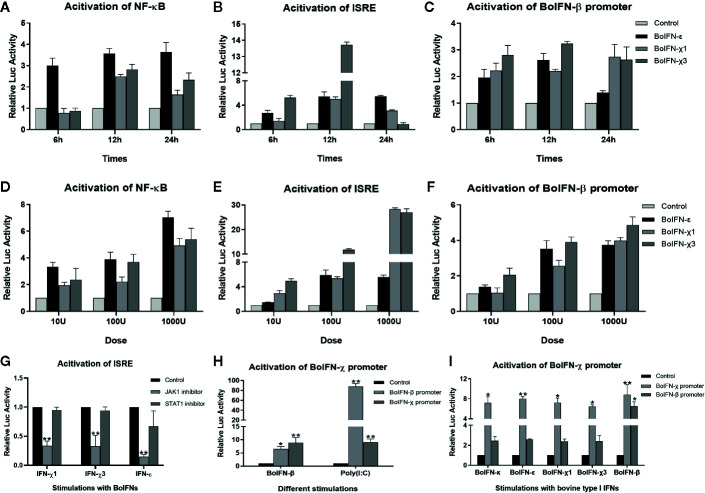
Promoter activation with BoIFN-χs. (A–F) Time/dose dependence of activation of promoters of BoIFN-β (pGL3-BoIFNβ)/ISRE (pISRE-TA-Luc)/NF-κB (pNFκB-TA-Luc) upon BoIFN-χs treatment. BL cells were transfected with 1.6 μg pGL3-BoIFNβ/pISRE-TA-Luc/pNFκB-TA-Luc and 0.04 μg of pRL-SV40-Renilla for 24 h, and then, cells were incubated with a different dose of BoIFN-χ1 and BoIFN-χ3 for different times. Then, the cells were collected for dual-luciferase reporter assay. BoIFN-ϵ was used as positive control. (G) Activation of the ISRE (pISRE-TA-Luc) promoter in BL cells upon BoIFN-χs treatment followed by treatment with a STAT1/JAK1 inhibitor. BL cells were pretreated with JAK1/STAT1 inhibitor for 2 h following treatment with BoIFN-χ1 (5 μg/mL) and BoIFN-χ3 (5 μg/mL) for another 12 h, and the cells were collected for dual-luciferase reporter assay. BoIFN-ϵ (5 μg/mL) was used as a positive control, and the cells without inhibitors were used as a mock-treated control. (H) Activation of the BoIFN-χ (pGL3-BoIFNχ) promoter. BL cells were transfected with 1.6 μg pGL3-BoIFNχ/pGL3-BoIFNβ and 0.04 μg of pRL-SV40-Renilla for 24 h, and then. BoIFN-β (5 μg/mL)/poly(I:C) (1 μg/mL) were incubated for another 12 h, and the cells were collected for dual-luciferase reporter assay. The cells transfected with pGL3-BoIFNχ were used as positive control, and the cells transfected with pGL3-basic vector were used as mock-treated control. (I) Activation of the BoIFN-χ promoter with bovine type-I IFNs. The wells without IFN treatment were used as the mock-treated control. Error bars indicate the standard deviation of three replicates. *P < 0.05, **P < 0.01.